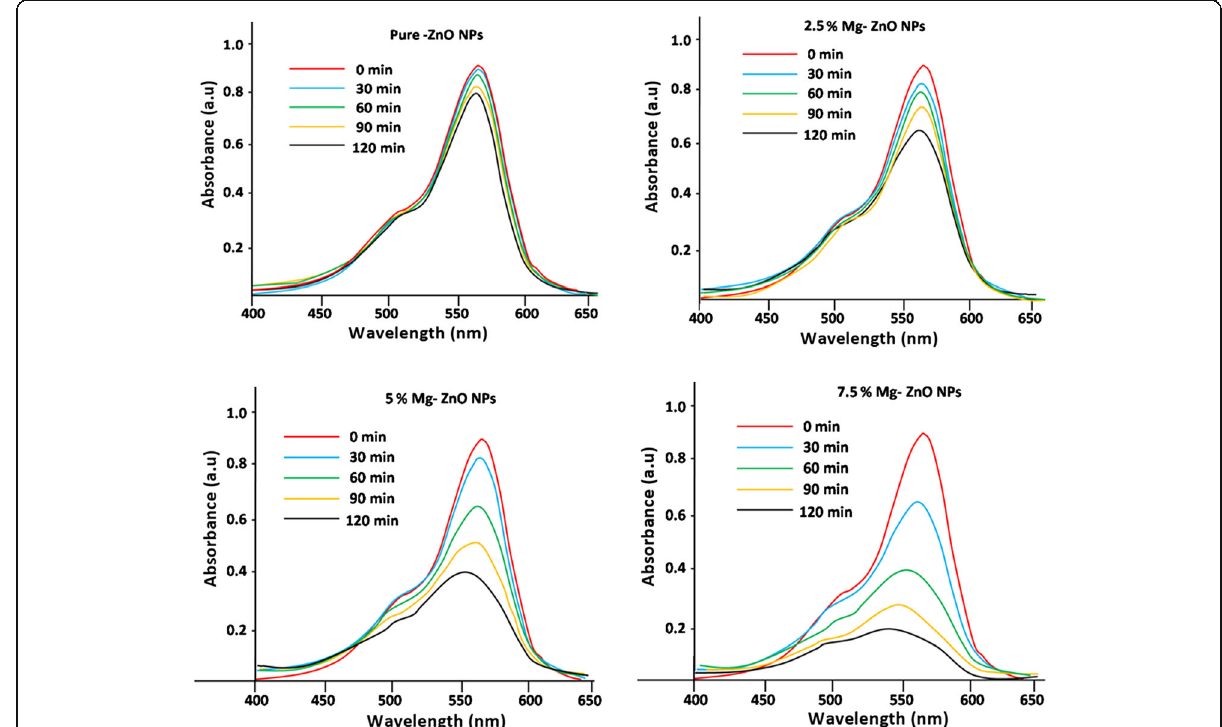
Fig. 7 Absorption spectral decrement of Rhodamine B dye aqueous solution degraded from (0 – 120